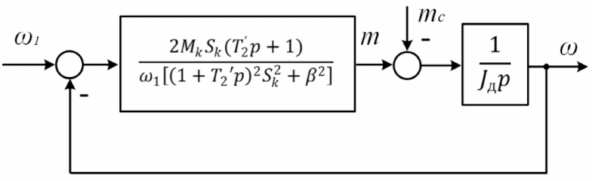
Figure 12. Structural diagram of IM with nonlinear link of torque